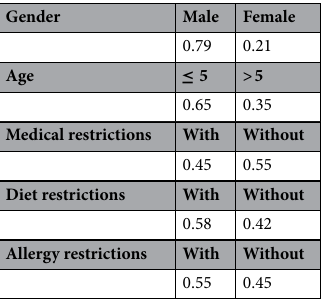
Table 3. Demographic characteristics of the targeted